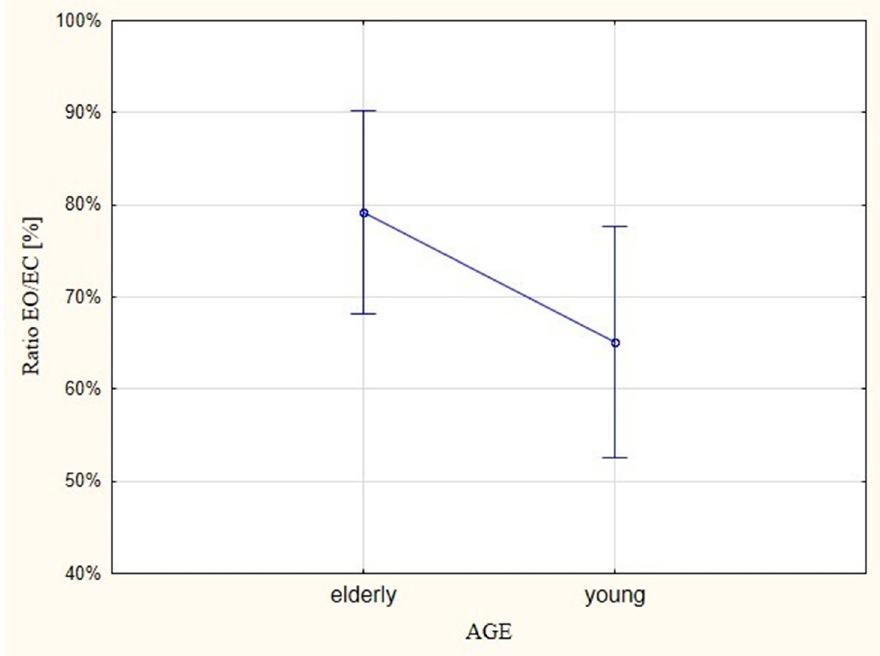
Figure 2. EMG ratios (ratios of synergistic and antagonistic muscles of the ankle joint) for eyes open (EO) versus eyes closed (EC) tests on young and elderly people.